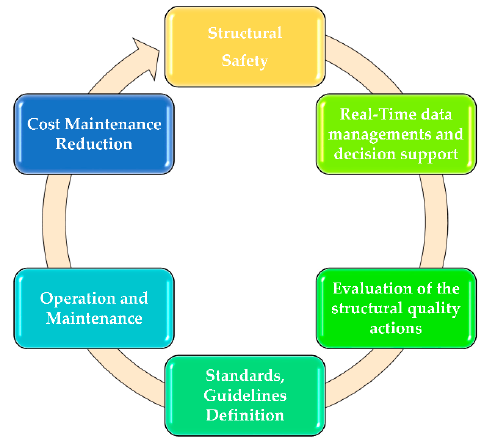
Figure 1. Diagram on the optional monitoring approach.